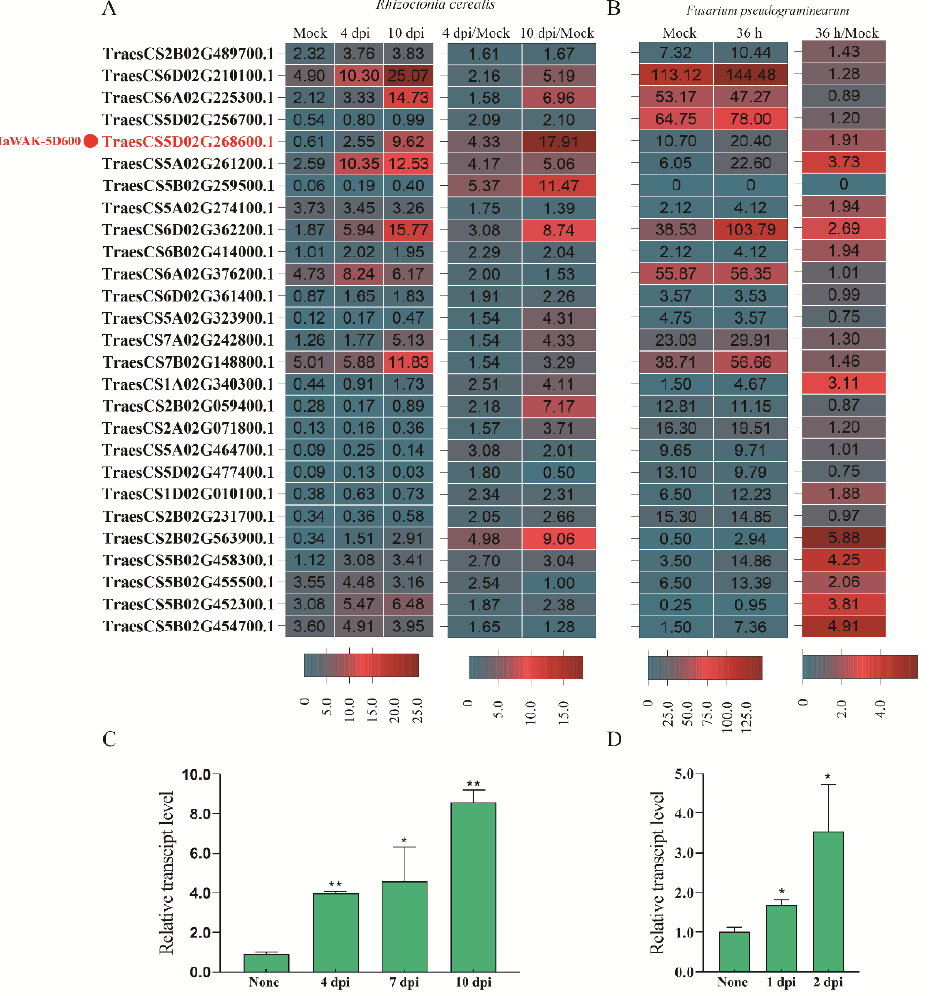
Figure 3. TaWAK-5D600 is involved in wheat responses to both sharp eyespot and Fusarium crown rot. ( A ) The transcript levels and fold change of the significantly upregulated 27 TaWAK genes in the RILs-R response to R. cerealis infection. ( B ) The transcript levels and fold change of the 27 R. cerealis induced TaWAK genes upon F. pseudograminearum infection in the online RNA-seq data (http://www.wheat-expression.com/ accessed on 25 August 2022) [32]. ( C ) Transcript levels of TaWAK-5D600 in sharp eyespot-resistant wheat line CI12633 at non-treatment and 4, 7, and 10 dpi with R. cerealis Rc207. ( D ) The transcript patterns of TaWAK-5D600 in FCR-mildly-resistant wheat line CI12633 at non-treatment and 1 and 2 dpi with F. pseudograminearum WHF220. TaWAK-5D600 transcript level at non-treatment is set to 1. TaActin gene was used as the internal control ( t -test: * p < 0.05; ** p < 0.01).